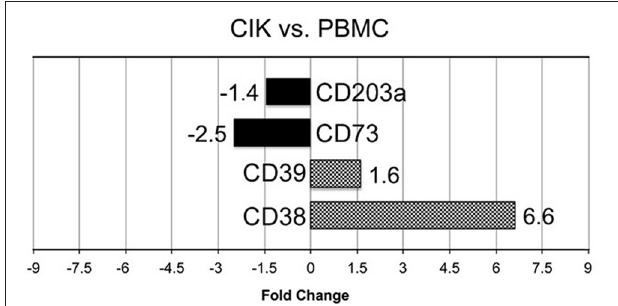
FIGURE 1 | Transcriptome analysis of CIK ectoenzymes. mRNA expression was analyzed in PBMC (day 1, absence of INF- γ ) and CIK cells (day 14) obtained from 3 GIST patients. The black blocks display the transcripts that are down-regulated during CIK differentiation; whereas, the chess pattern displays the mRNAs that are up-regulated during CIK